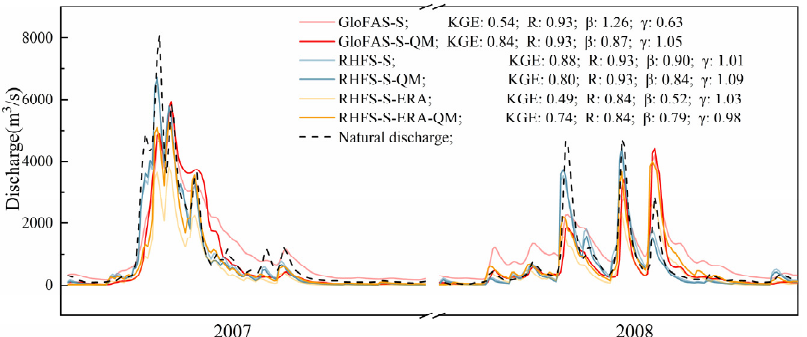
Figure 5. Time series of discharge simulations and the natural discharge for the verification period (2007, 2008, June–October), and associated KGE, R, β , γ . KGE = modified Kling–Gupta efficiency coefficient; R = correlation; β = bias errors; γ = variability error.